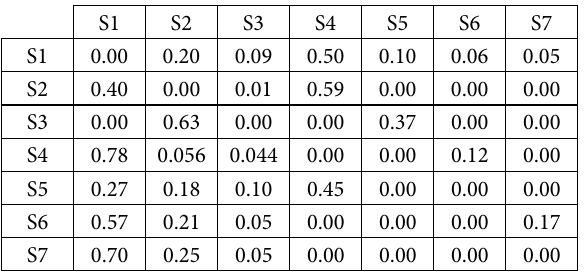
Table 4. Probability transition matrix p ij